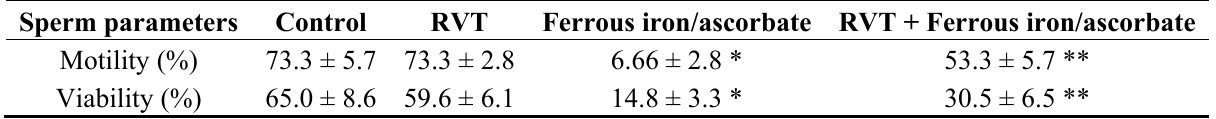
Table1. Spermatozoa